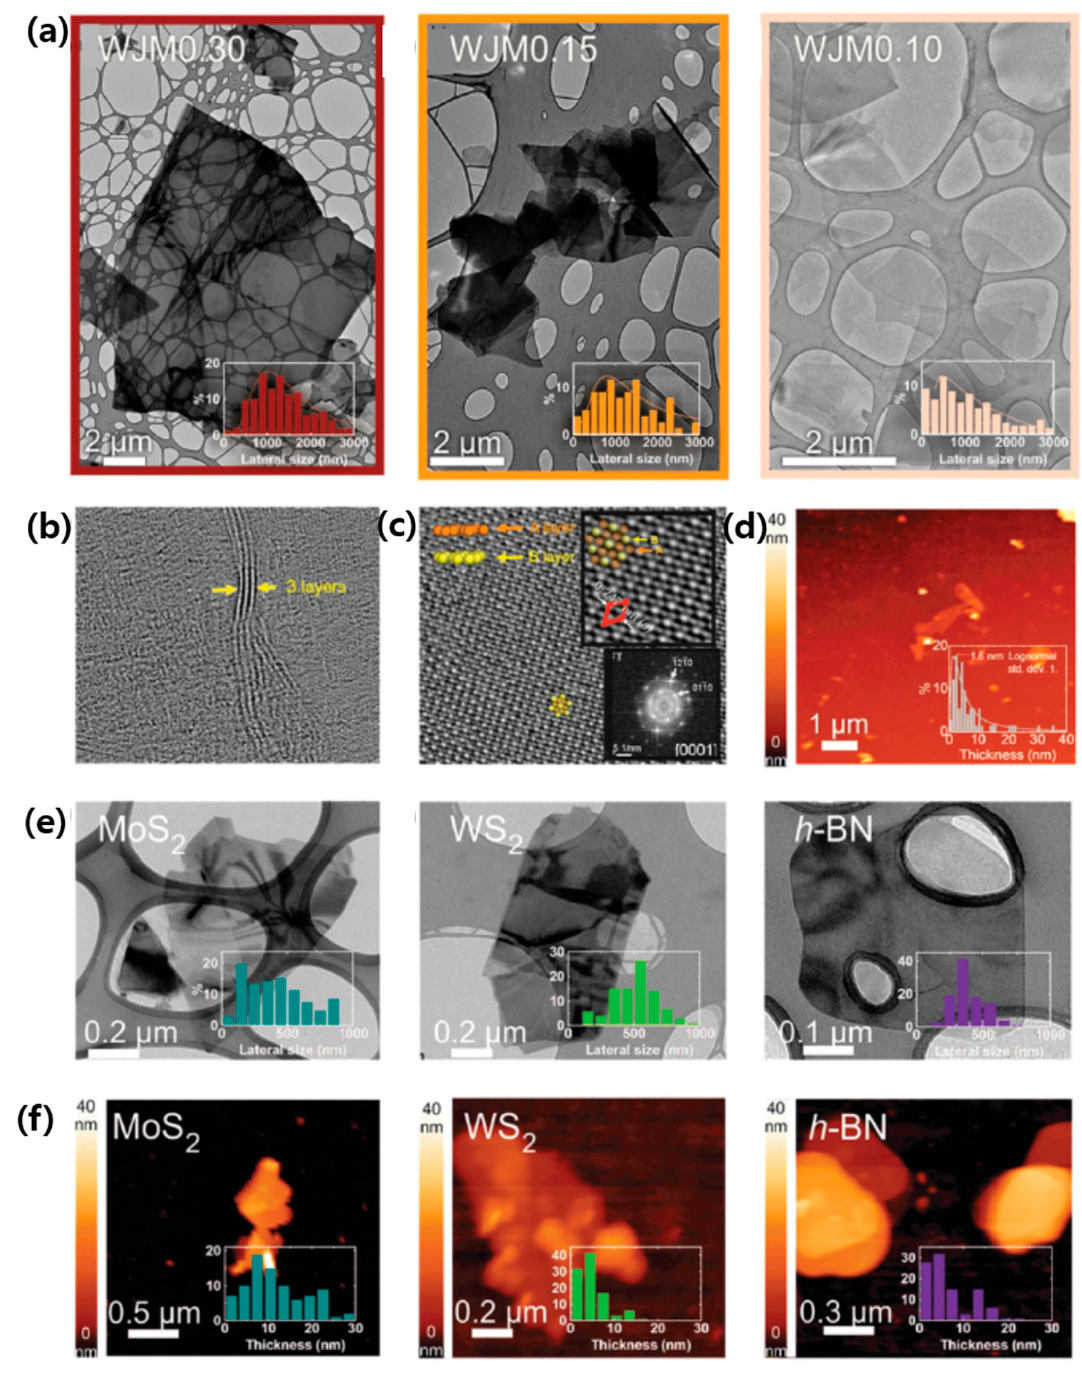
Figure 6. ( a ) TEM images and lateral size distribution histogram (inset) of graphite nanosheets processed at WJM with different nozzle diameter (0.30, 0.15, and 0.10 denote the nozzle diameter 0.30, 0.15, and 0.10 mm, respectively), ( b ) HRTEM image of three-layer graphene, ( c ) HRTEM image of WJM 0.10 flake showing A–B stacking (upper inset: closed-view area of nanosheet indicated by yellow and orange circles displays hexagonal unit cell of graphite, bottom inset: FFT image), ( d ) AFM image of WJM 0.10 flake (inset: thickness distribution histogram), ( e ) TEM images and lateral size distribution histogram (inset) of MoS 2 , WS 2 , and h-BN nanosheets, ( f ) AFM images and thickness